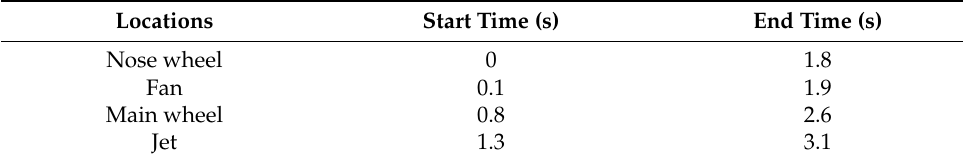
Table 3. Durations of the forces applied for the transient simulations.